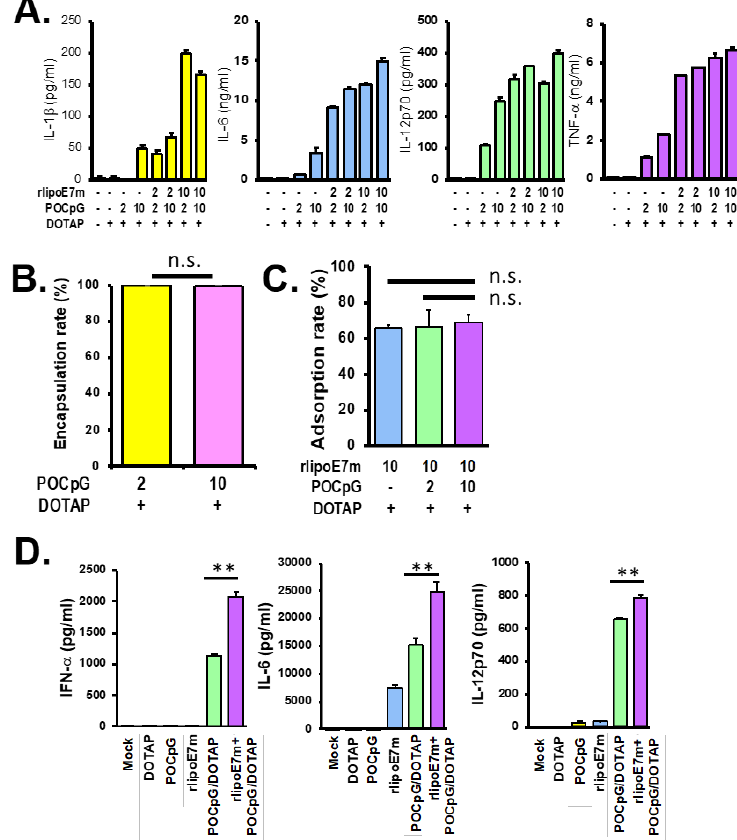
Figure 1. A bone marrow-derived dendritic cells (BMDC)-based bioassay was used to optimize the composition of recombinant lipoprotein with liposomal CpG. ( A ) Two micrograms or 10 µ g rlipoE7m and POCpG were mixed with 100 nmole DOTAP to stimulate 2 × 10 6 BMDCs in 1 mL medium to produce cytokines, such as IL-1 β , IL-6, IL-12p70, and TNF- α . After 18 h of incubation, cytokines in the supernatant were determined by ELISA. ( B ) Two micrograms or 10 µ g POCpG were encapsulated by 100 nmole DOTAP liposomes. The encapsulation rate was calculated by the formula: (encapsulation rate (%) = (1 − free POCpG / loading POCpG) × 100%). ( C ) The recombinant protein rlipoE7m was adsorbed by 100 nmole DOTAP liposomes only, 2 µ g POCpG-encapsulated DOTAP liposomes, and 10 µ g POCpG-encapsulated DOTAP liposomes. The adsorption rate was calculated by the formula: (adsorption rate (%) = (1 − free rlipoE7m in solution / loading rlipoE7m) × 100%). ( D ) A total of 1x10 6 plasmacytoid dendritic cells (pDCs) cultured from bone marrow cells were incubated with the indicated lipoprotein and liposome combinations for 18 h. Concentrations of IFN- α , IL-6, and IL-12p70 in the supernatant were determined by ELISA. (** p < 0.01). The data were collected and analyzed from two independent experiments and n.s. represents no significant di ff